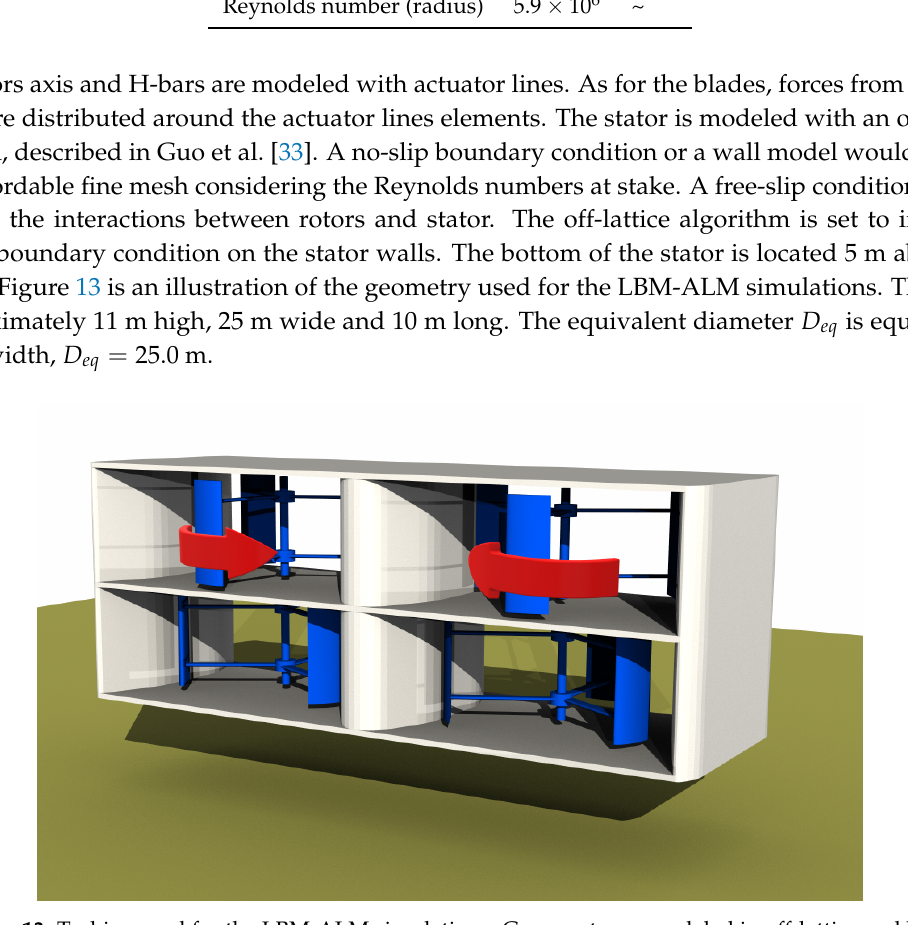
Figure 13. Turbine used for the LBM-ALM simulations. Grey parts are modeled in off-lattice and blue parts with forces. The direction of rotation is indicated with red